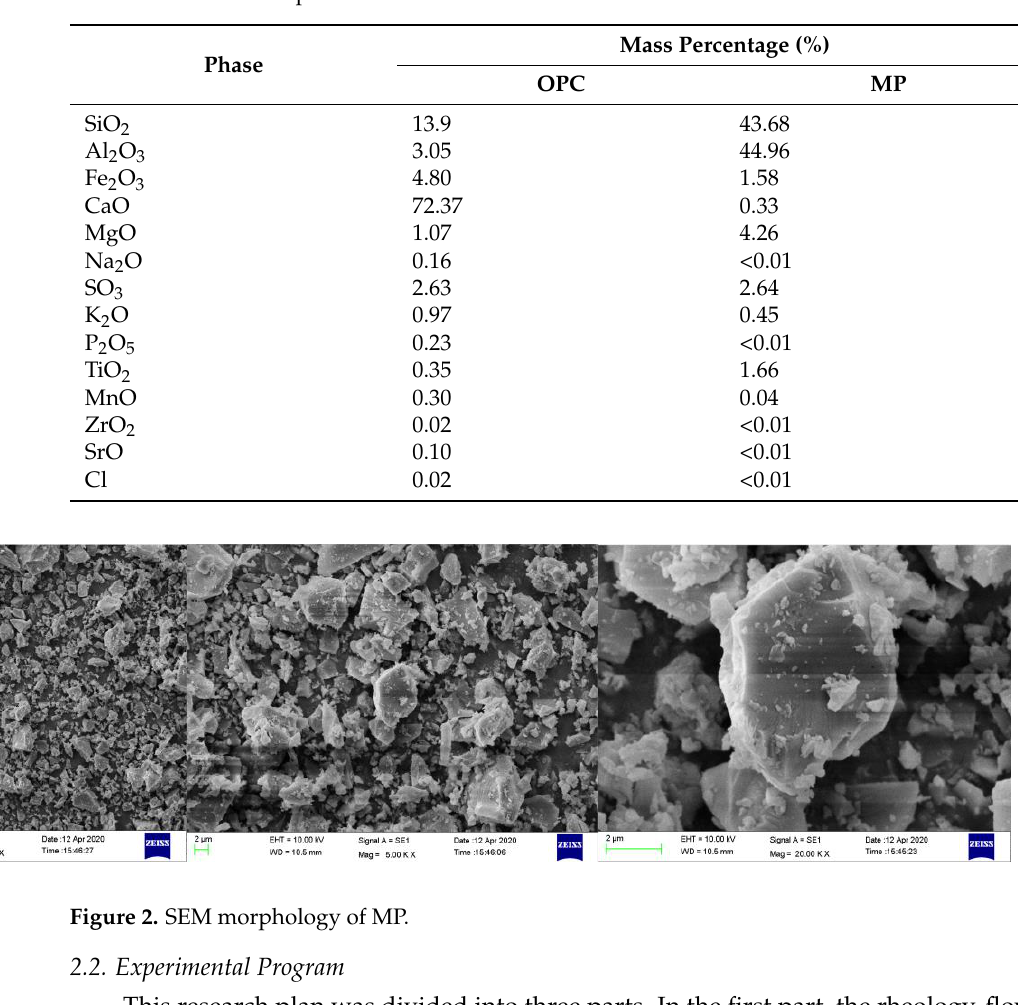
Table 1. Chemical compositions of MP and OPC.